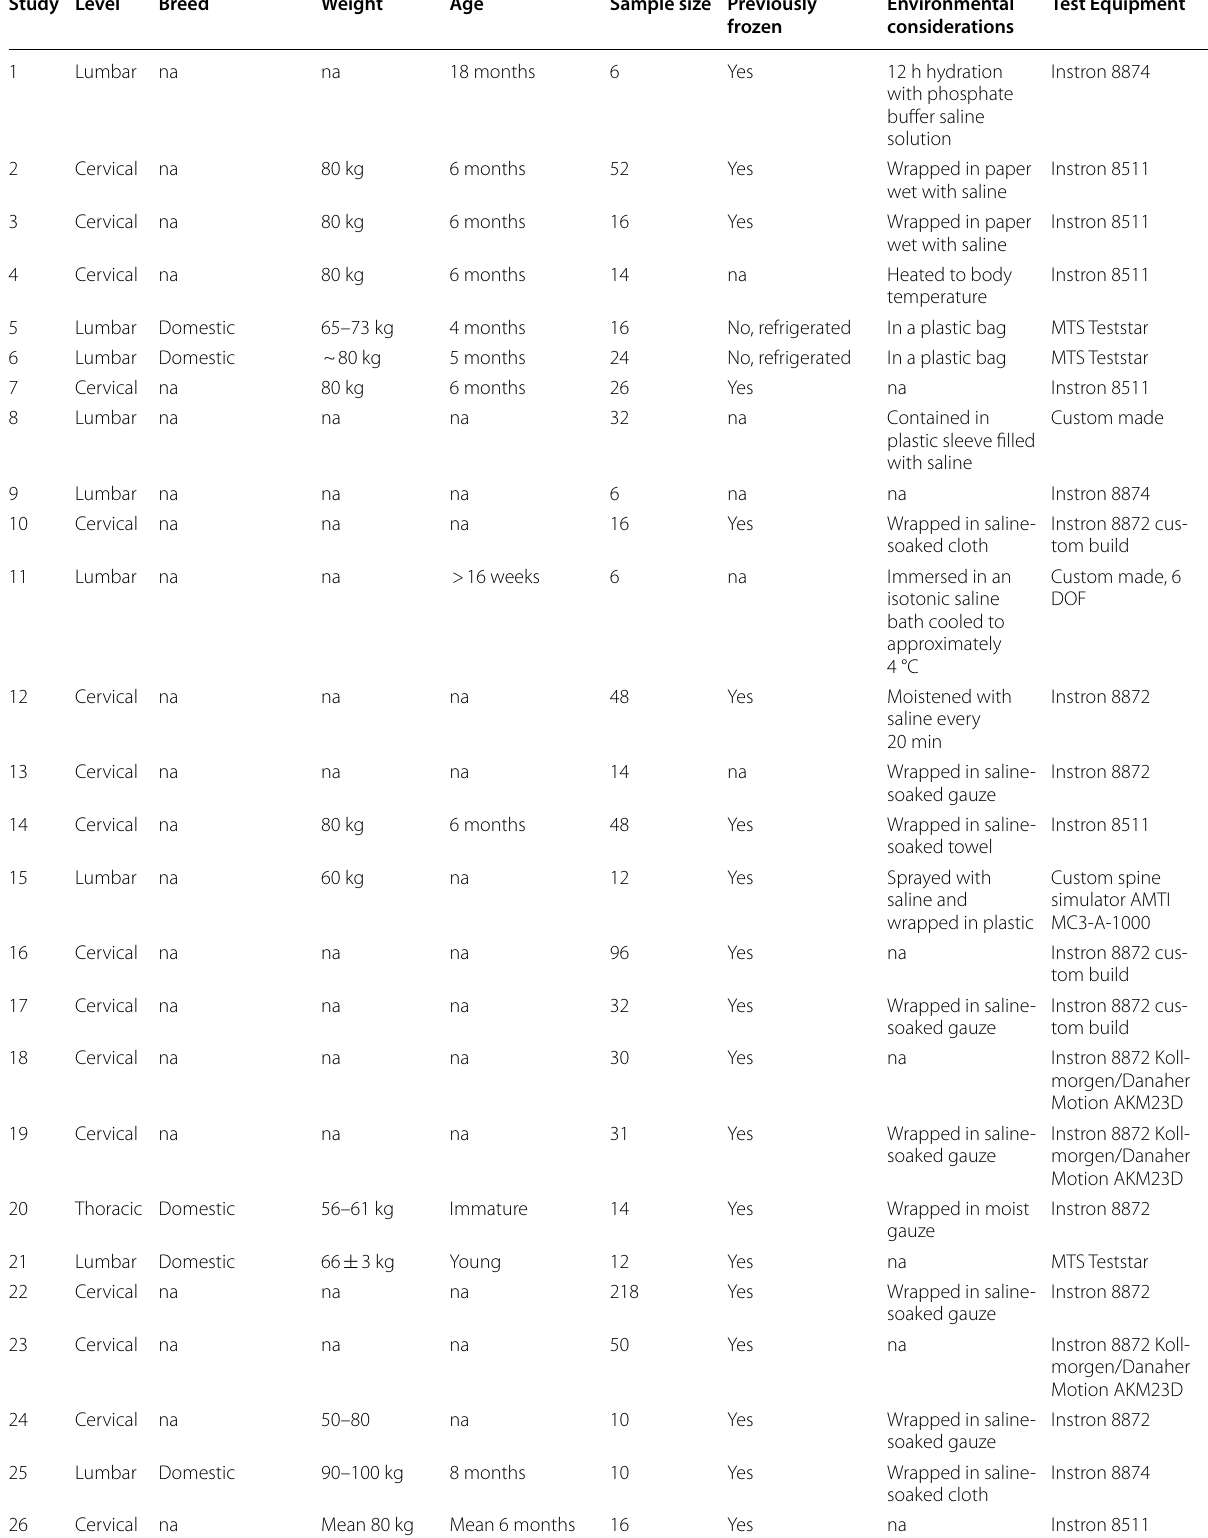
Table 2 Material information and study